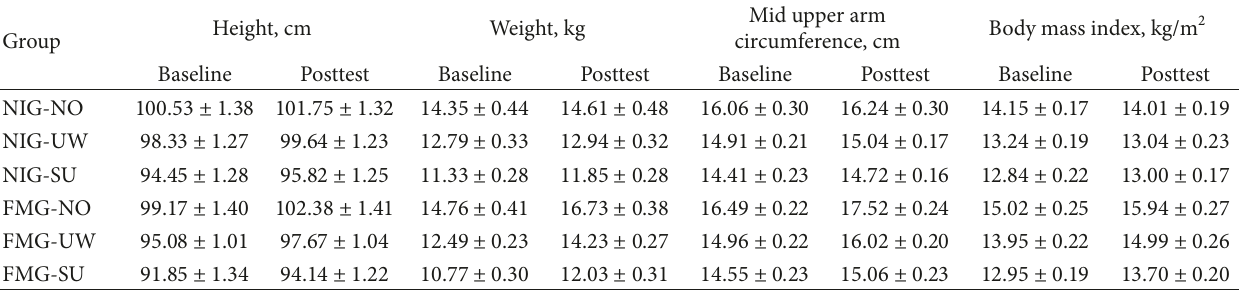
Mid upper arm Body mass index, kg/m 2 circumference, cm